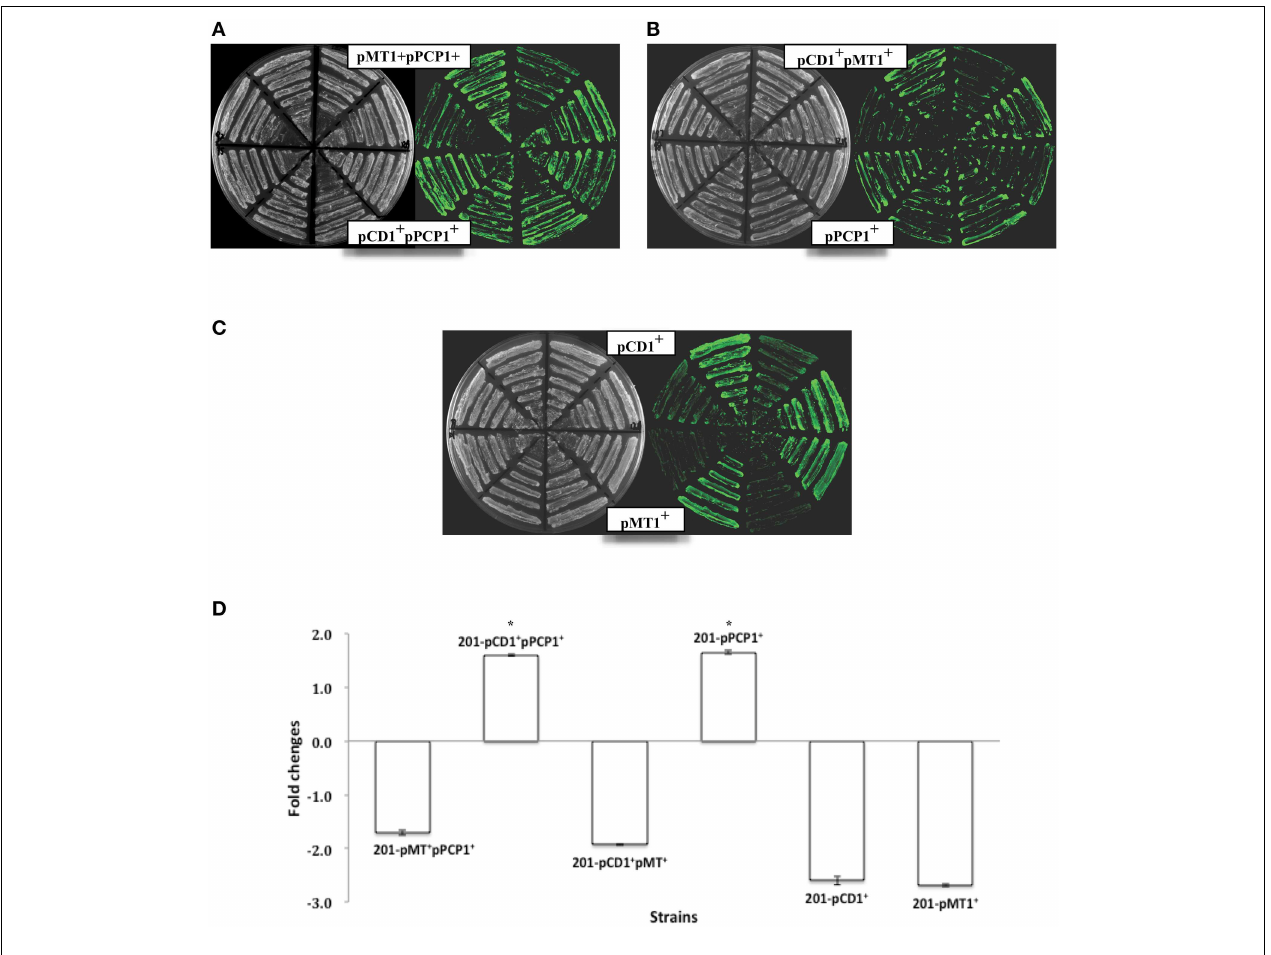
strains are shown (A–C) . The corresponding quantitative results are also shown (D) , in which the asterisks indicate statistically significant differences compared to the values detected in strain MG1655 shown in Figure 1